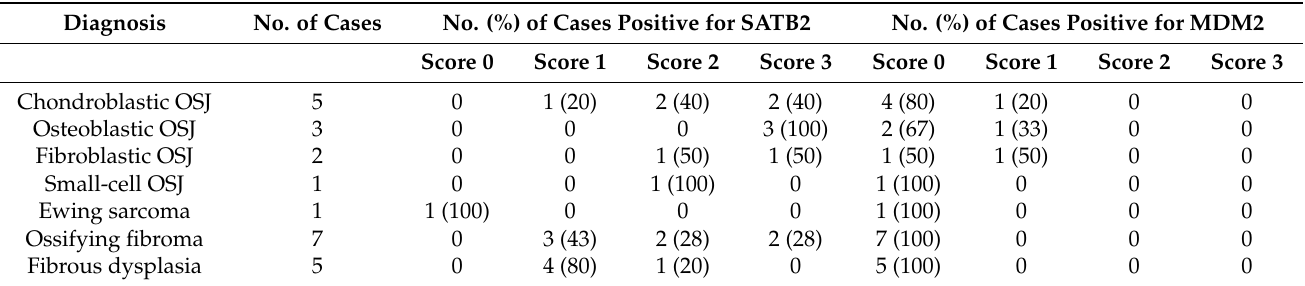
Table 2. Comparative SATB2 and MDM2 immunohistochemistry in primary osteosarcomas, Ewing sarcoma, and benign fibro-osseous lesions of the jaw.